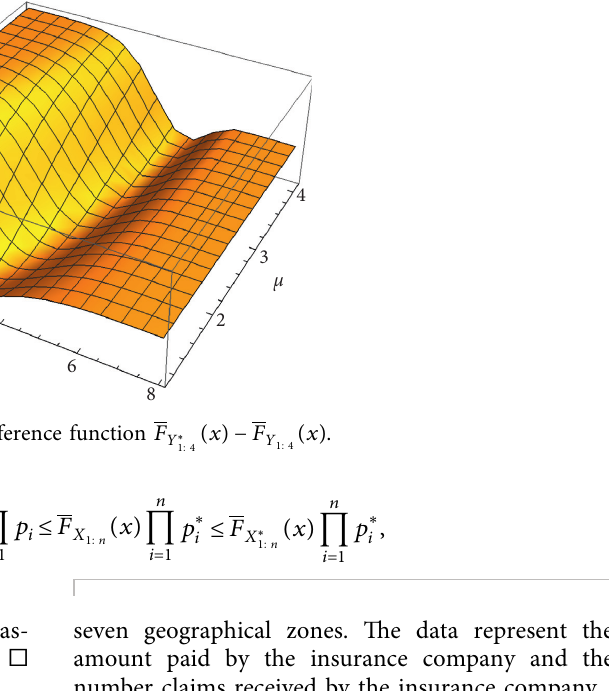
( x ) − F ( x ) , for all x � − ln u and u ∈ ( 0 , 1 ] . Y ∗ 1 : 4 Y 1 : 4